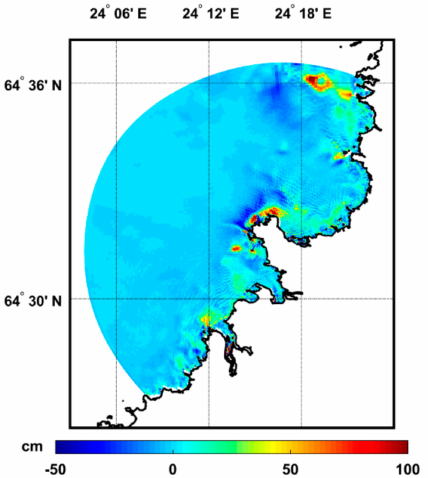
Figure 6. Modeled sediment layer thickness change after the annual period of realistic external